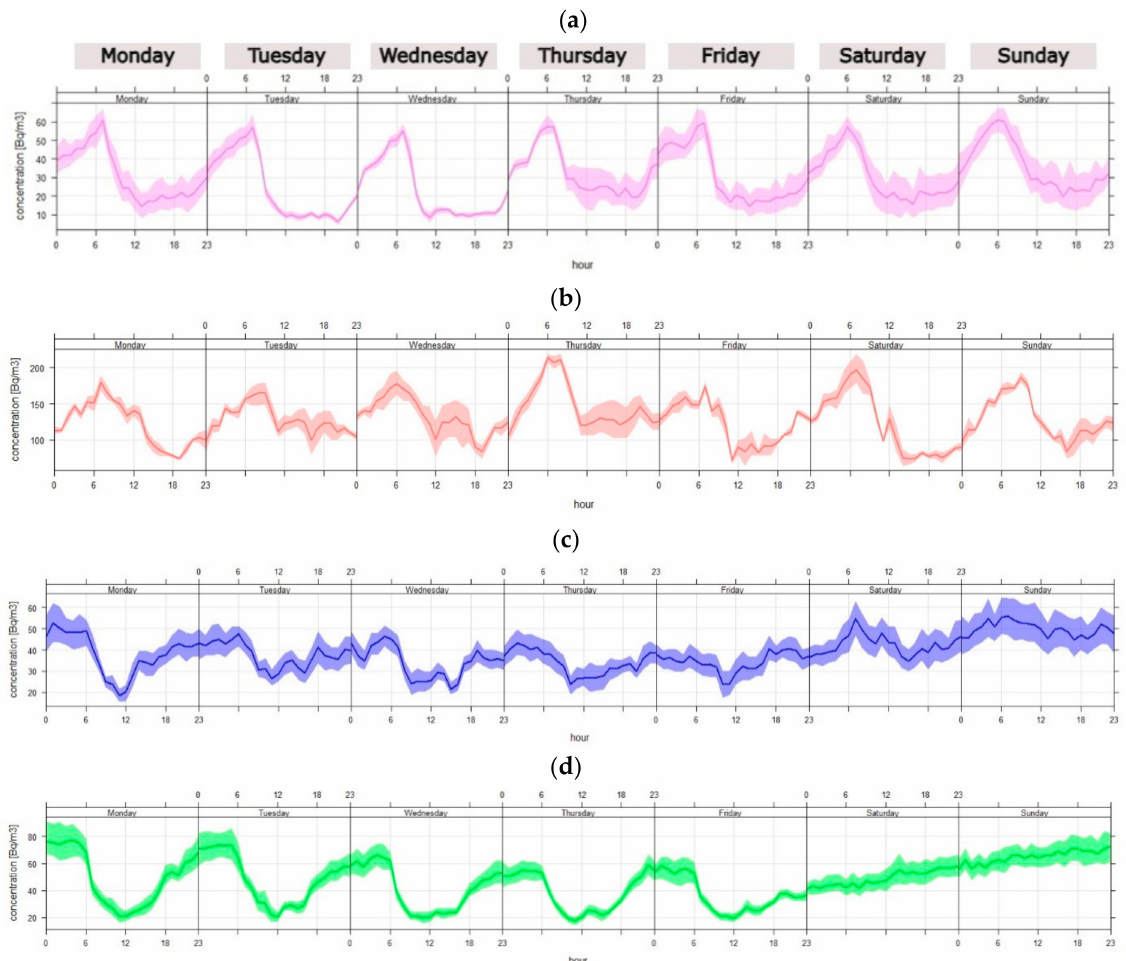
Figure 4. Differentiation of radon during the week (Monday to Sunday) for rooms ( a ) A, ( b ) B1, ( c ) C1 and ( d )